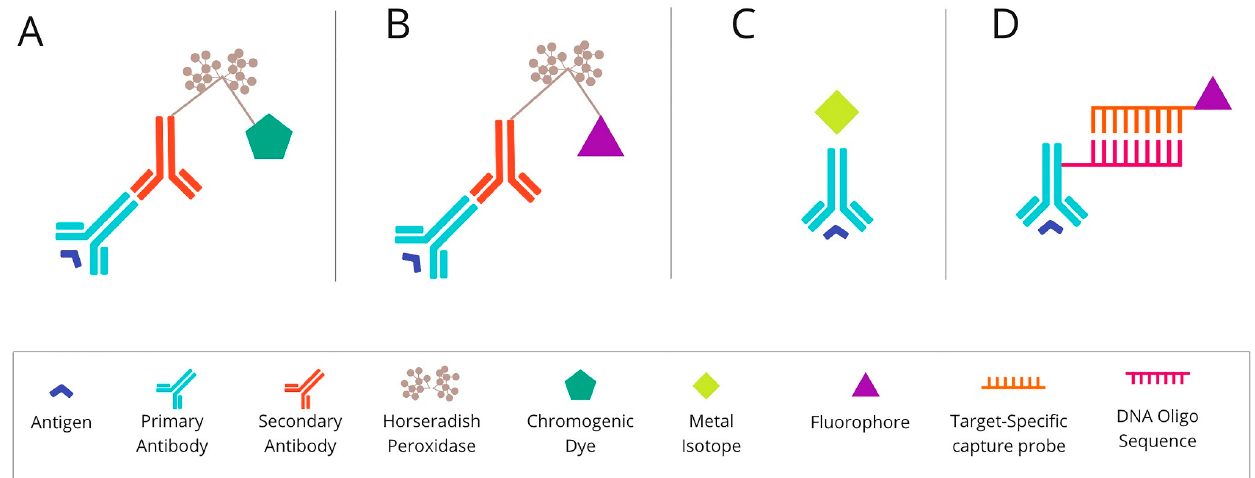
Figure 1. The basic mechanism of each of the mIHC/IF techniques. ( A ) Chromogenic-based: antigen-specific primary antibody is bound to a secondary antibody, conjugated with HRP enzymes labelled with chromogen. ( B ) Fluorescence-based: antigen-specific primary antibody is attached to a secondary antibody conjugated with HRP enzymes. Detection is achieved using the fluorophore-labelled HRP substrate, tyramide. ( C ) Metal-based: a primary antibody bound to the target antigen is labelled with an isotopically pure metal-chelator tag. ( D ) DNA-barcoding-based: a primary antibody bound to the target antigen is labelled with a unique DNA oligonucleotide tag. Subsequently, a complementary strand of DNA coupled to a specific fluorophore is attached. Abbreviations: